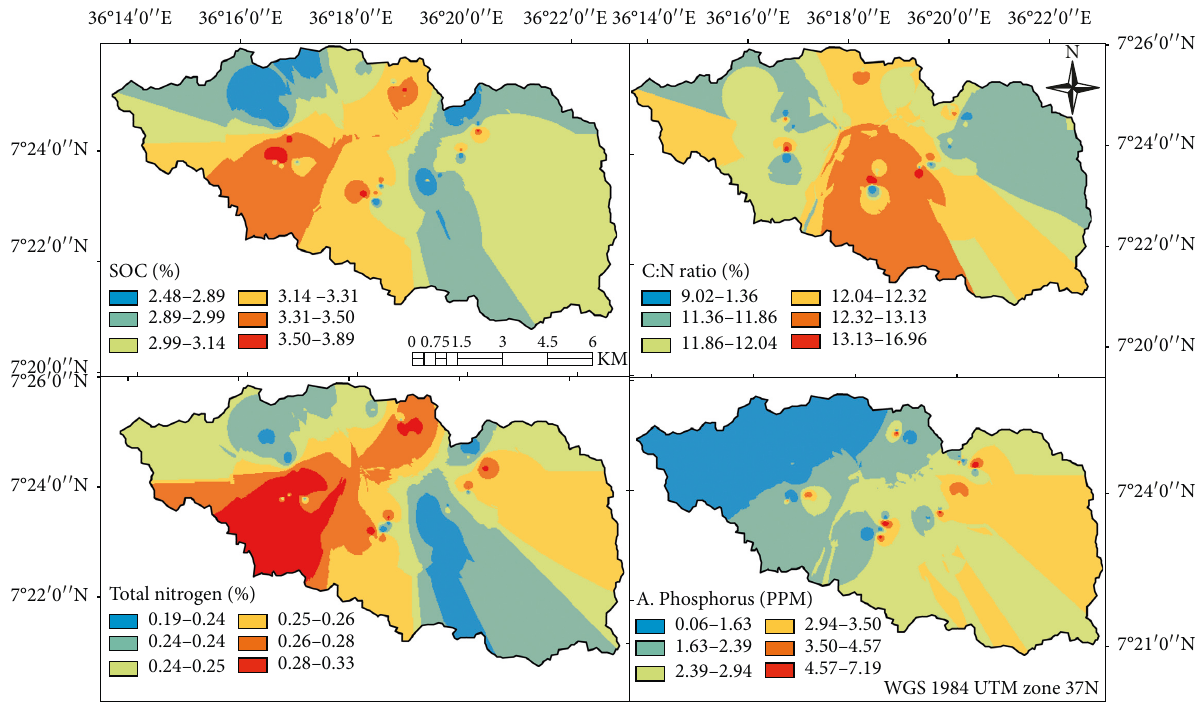
Figure 6: Map of the spatial distribution of SOC, TN, C :N ratio, and AP in the Geshy